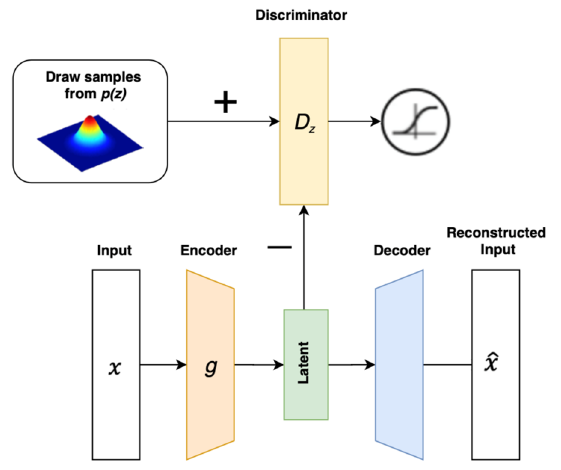
Figure 1. Architecture of the adversarial autoencoder (AAE).